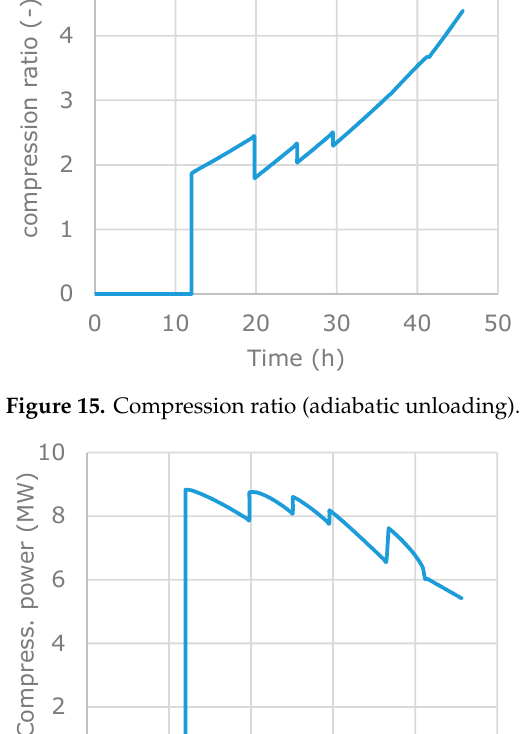
Figure 14. Mass of CNG in the pressure vessels (adiabatic unloading).